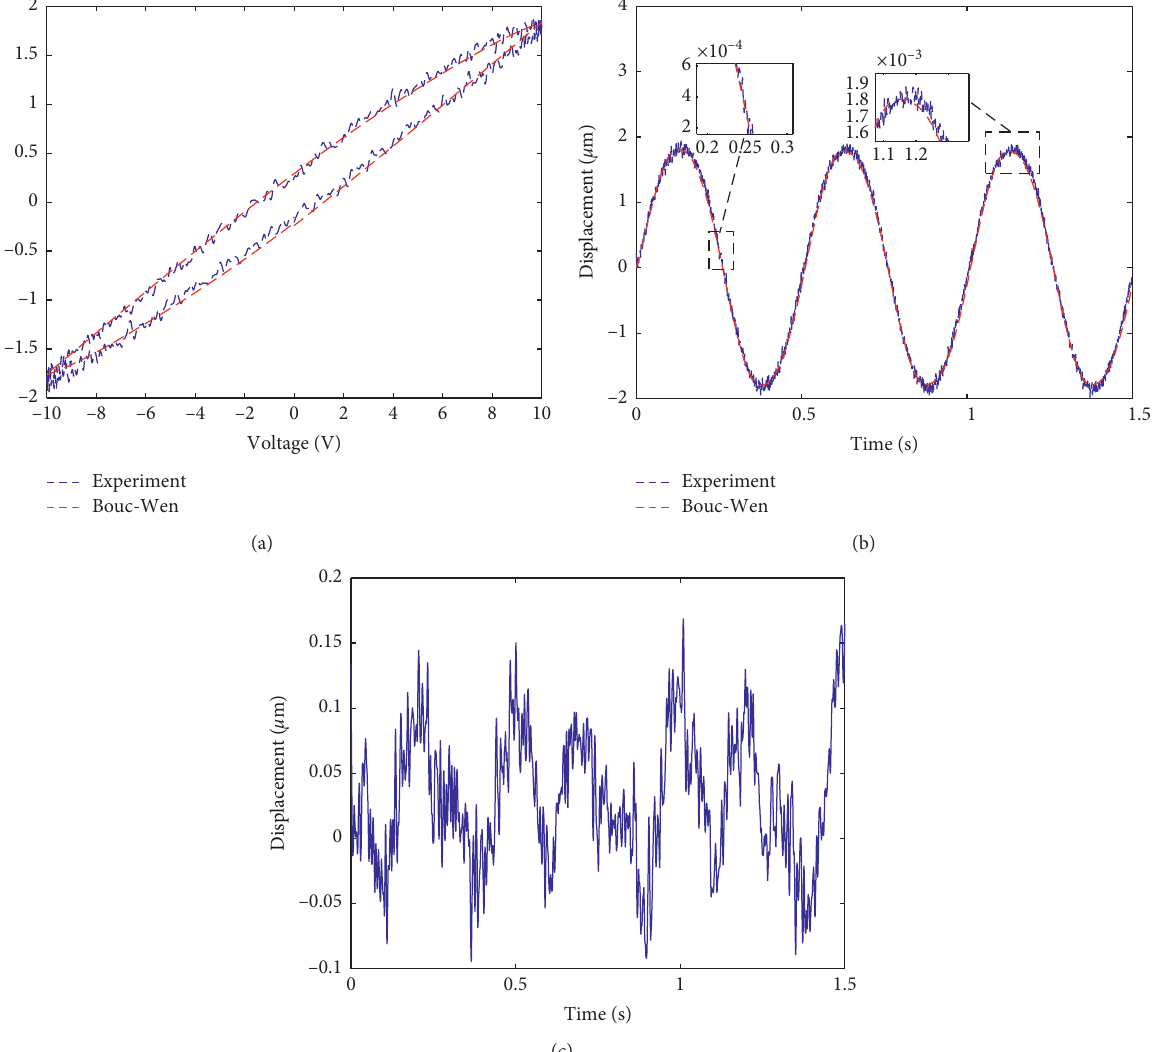
Figure 11: Y -direction identification results. (a) Comparison between the hysteresis model and the experimental data. (b) Displacement tracking of the hysteresis model. (c) Tracking error in the Y